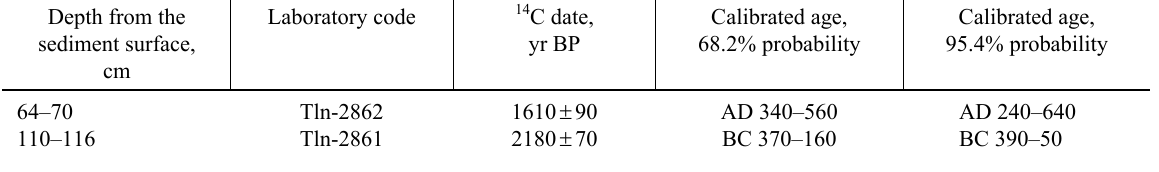
Table 1. Radiocarbon dates (yr BP) and calibrated ages (AD/BC) of sediment samples from the Lake Kooraste Kıverj(cid:228)rv core Depth from the sediment surface,